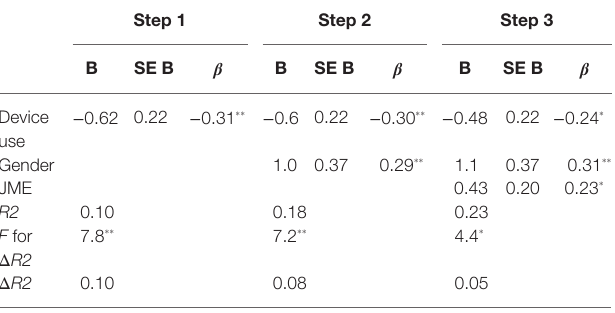
TABLE 9 | Summary of hierarchical regression analysis for variables predicting SEDCI-2 – Pragmatics ( n =